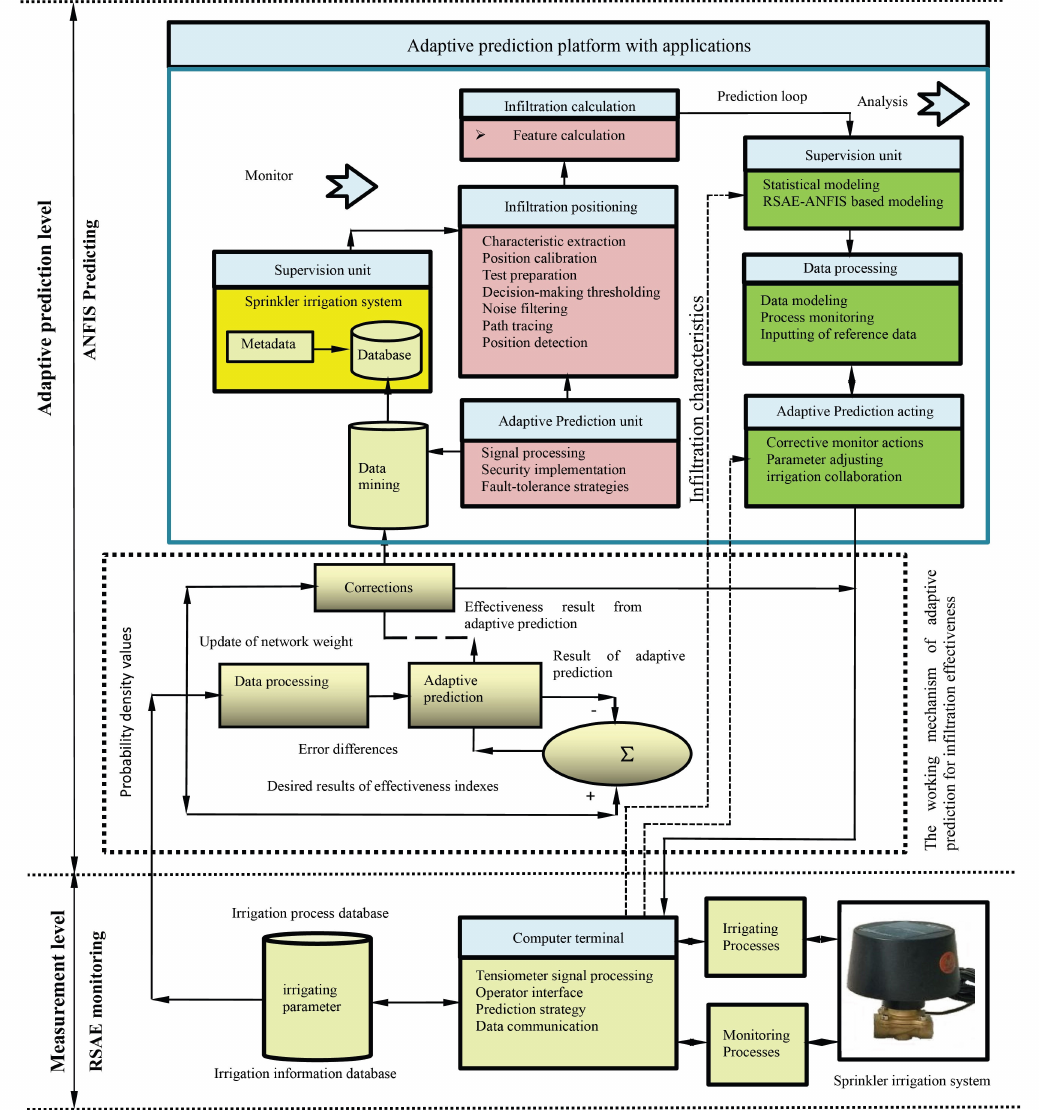
Figure 3. The measurement and adaptive prediction levels of the Regularized Sparse Autoencoder–Adaptive Network- based Fuzzy Inference System (RSAE–ANFIS), in which droplet infiltration could be measured from soil moisture sensors and transmitted to intelligent prediction